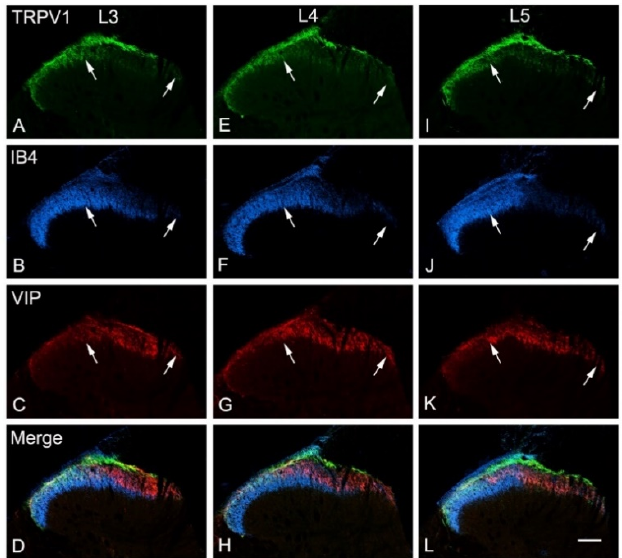
Figure 3. Confocal images of transverse sections of L3, L4 and L5 spinal segments showing the immunoreactivity of TRPV1, IB4 and VIP 14 days after intraplantar injection of RTX (0.002%) in the left hind paw. RTX treatment caused marked downregulation of TRPV1 ( A , E , I ), IB4 ( B , F , J ) in the medial aspect of the dorsal horn (between two white arrows) of L3–L5 segments, and in the same areas, VIP was upregulated ( C , G , K ). The area labelled between white arrows receives primary afferents originating from L3, L4 and L5 nerves, which supply the plantar skin in rats. ( D , H , L ) are merged images. Scale bar 100 µm.